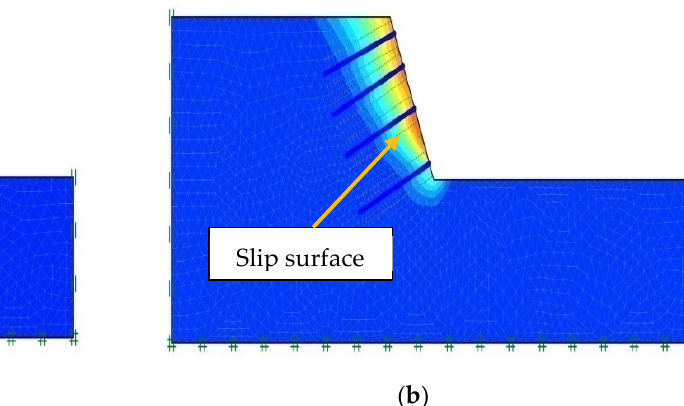
Figure 5. Effect of nail inclination on FS of slopes with different backslope inclinations: ( a ) α = 0 ◦ , ( b ) α = 10 ◦ , and ( c ) α = 20 ◦ .